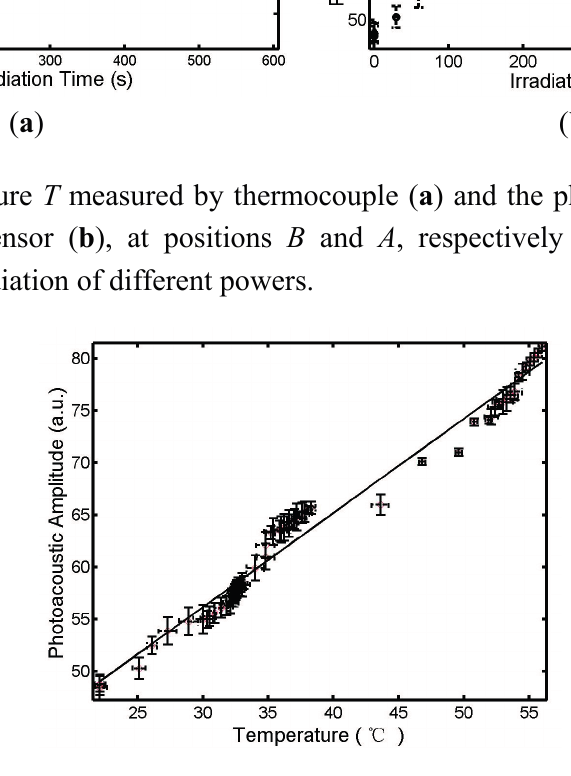
Figure 3. Relationship between photoacoustic signal at position A and temperature at position B (see Figure 1). The straight line is a regression curve at 95% confidence ( r 2 > 0.94 and p -value <